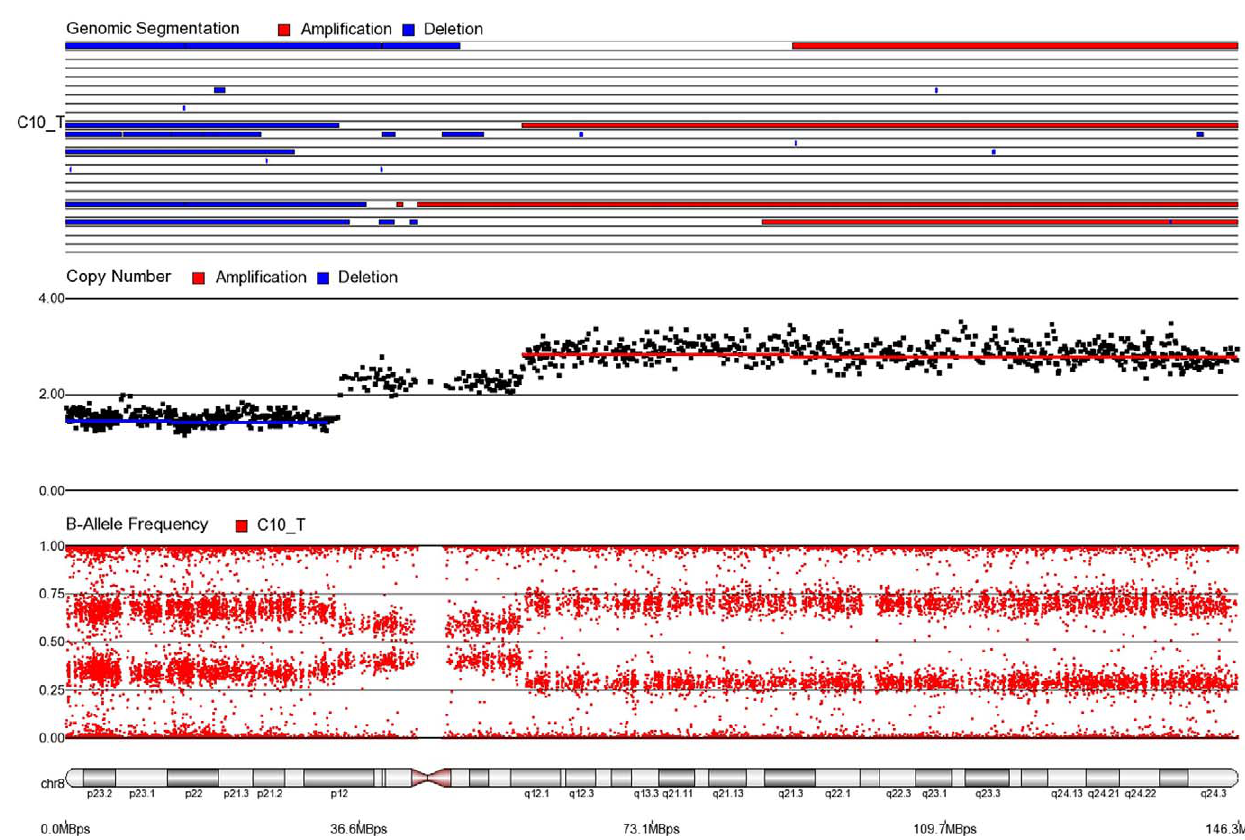
Figure 2. Mosaic monoallelic amplification and deletion in chromosome 8 for CRC tissue sample C10_T. In 8q (where BAF=0.34, 0.66 and CN=2.9), approximately 90% of cells have monoallelic amplifications (AAB or ABB). In 8p (where BAF=0.35, 0.65 and CN=1.55), approximately 40% of cells have monoallelic deletions (A_ or B_).